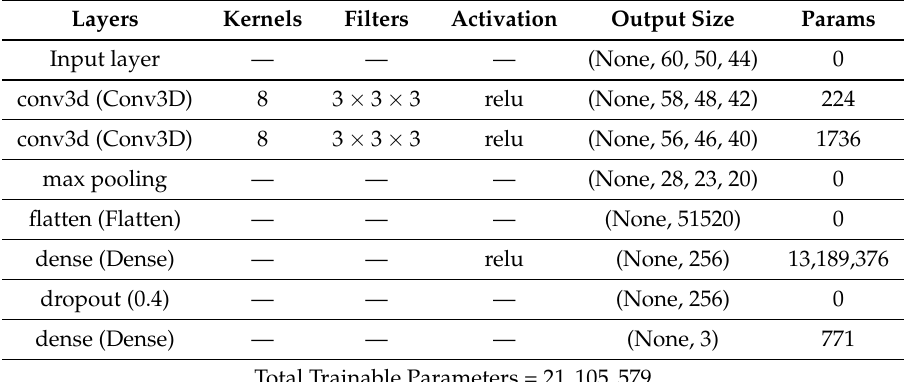
Figure 7. Confusion matrix for 17 blind spatial-spectral cubes, where ( a , c , e ) represent the confusion matrix of Support Vector Machine (SVM), K -Nearest Neighbor (KNN) and Deep Learning (DL) model using proposed band reduction method; and ( b , d , f ) represents the confusion metrics for entire spectral bands; ( g , h ) represent the training and validation loss/accuracy curves for the proposed architecture. Table 1. Structure for 3D-DL